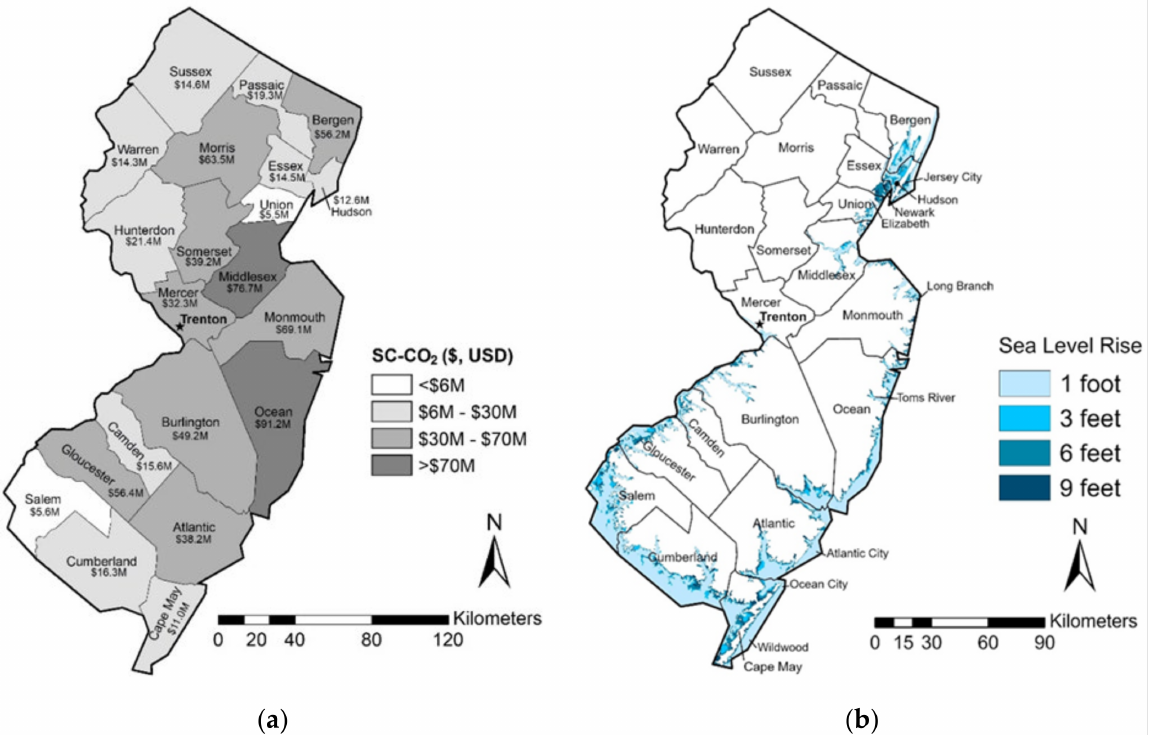
Figure 4. ( a ) Detection and attribution map of realized social cost of C because of land conversions in New Jersey (USA). Realized total dollar value of mid-point total soil carbon (TSC) for newly “developed” land covers (open space, low, medium, and high intensity) from 2001 to 2016 in New Jersey by county based on a social cost of C (SC-CO 2 ) of $46 per metric ton of CO 2 applicable for the year 2025 (2007 U.S. dollars with an average discount rate of 3% [1]). Total value for the state is $722.2 M. ( b ) Projections of future sea rise due to climate change in New Jersey